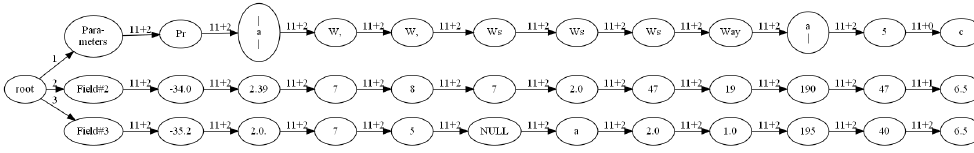
Figure 17. Tree for scanned table image 2.